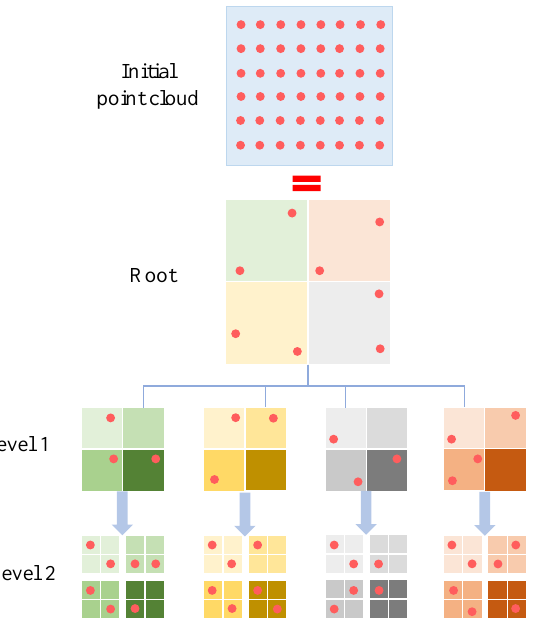
Figure 6. Potree’s octree structure explained in